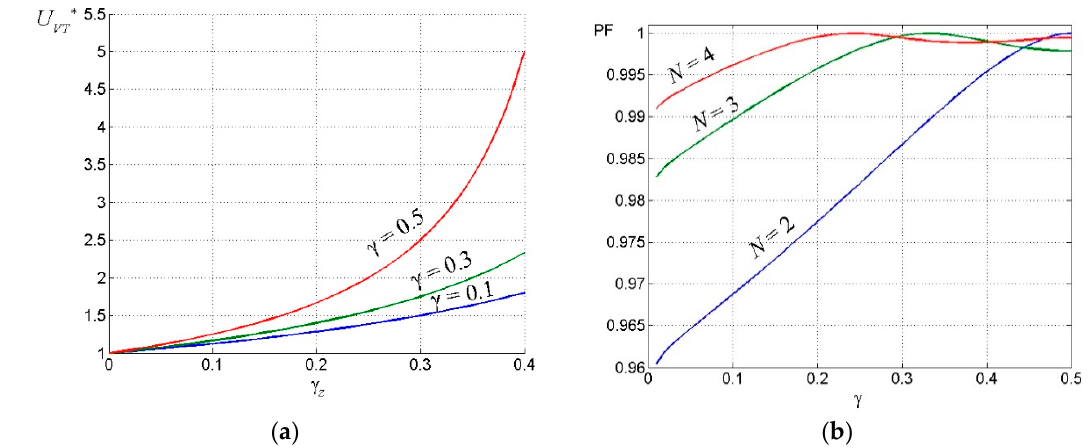
Figure 11. Input transistor relative overvoltage U T1 * versus duty cycle γ and zero current interval duration γ z ( a ); power factor value versus duty cycle γ and cell number N ( b ).